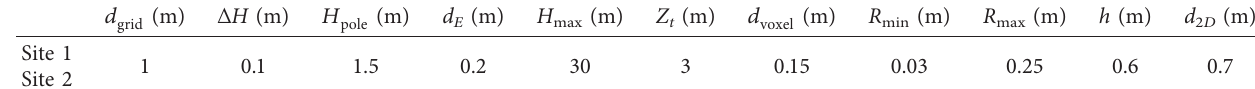
Table 2: Input parameters for PLO detection.